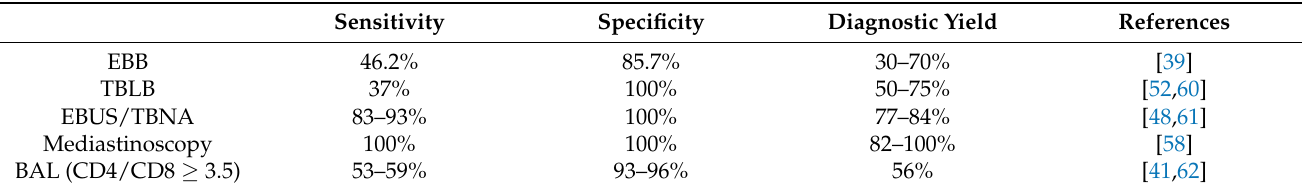
Table 1. Sensitivity and specificity of the main diagnostic procedures in suspicion of pulmonary